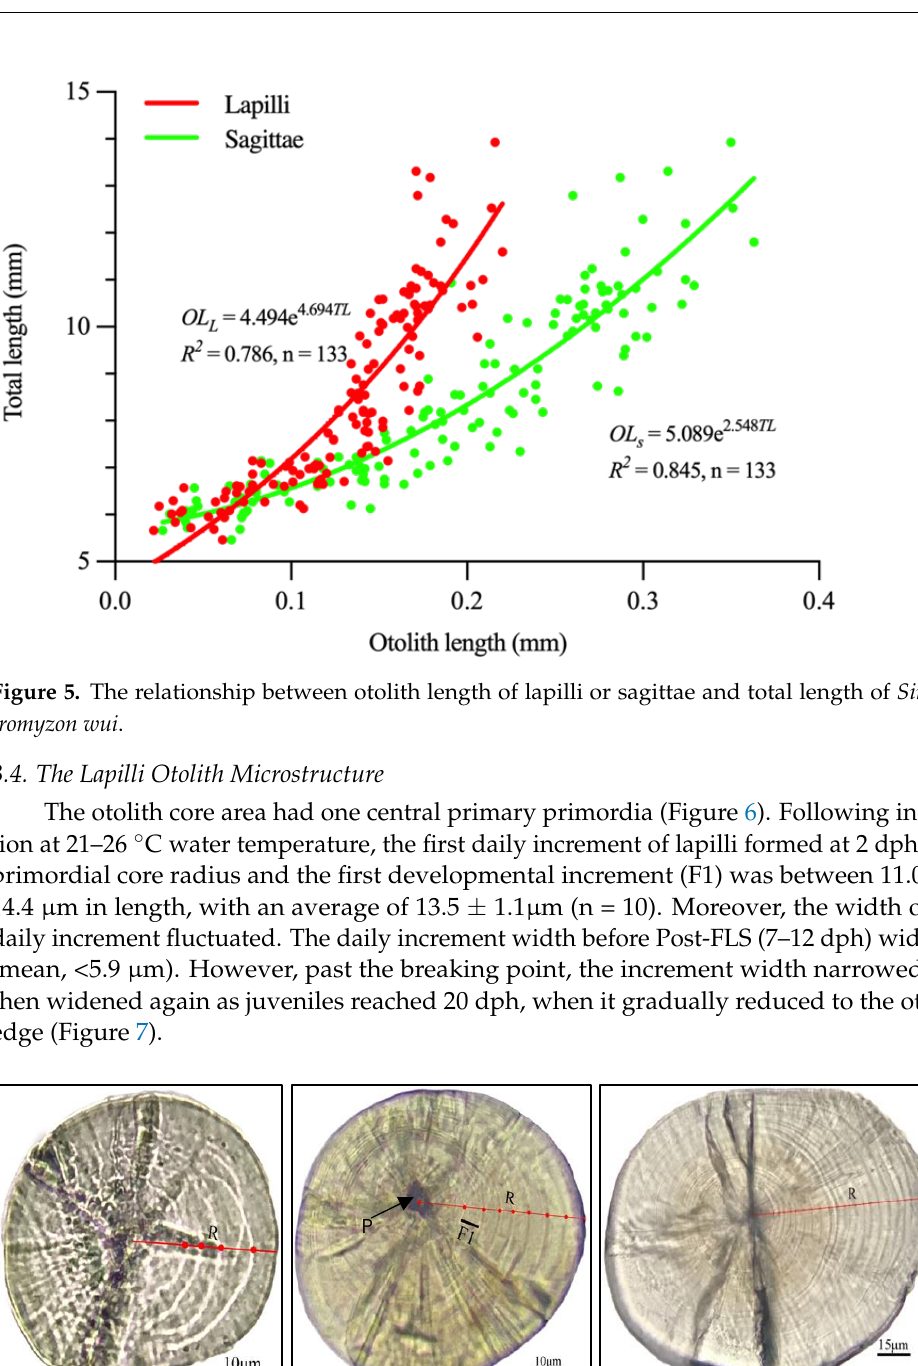
Figure 6. Lapilli otoliths of Sinogastromyzon wui. ( a ) The lapillus otolith of larva at 5 dph; showing the radius (R) along which increments were read and measured. ( b ) The lapillus otolith of larva at 9 dph, showing the primordium (P) and the first increment (F1). ( c ) The lapillus otolith of larva at 23 dph, showing the radius (R) along which increments were read.